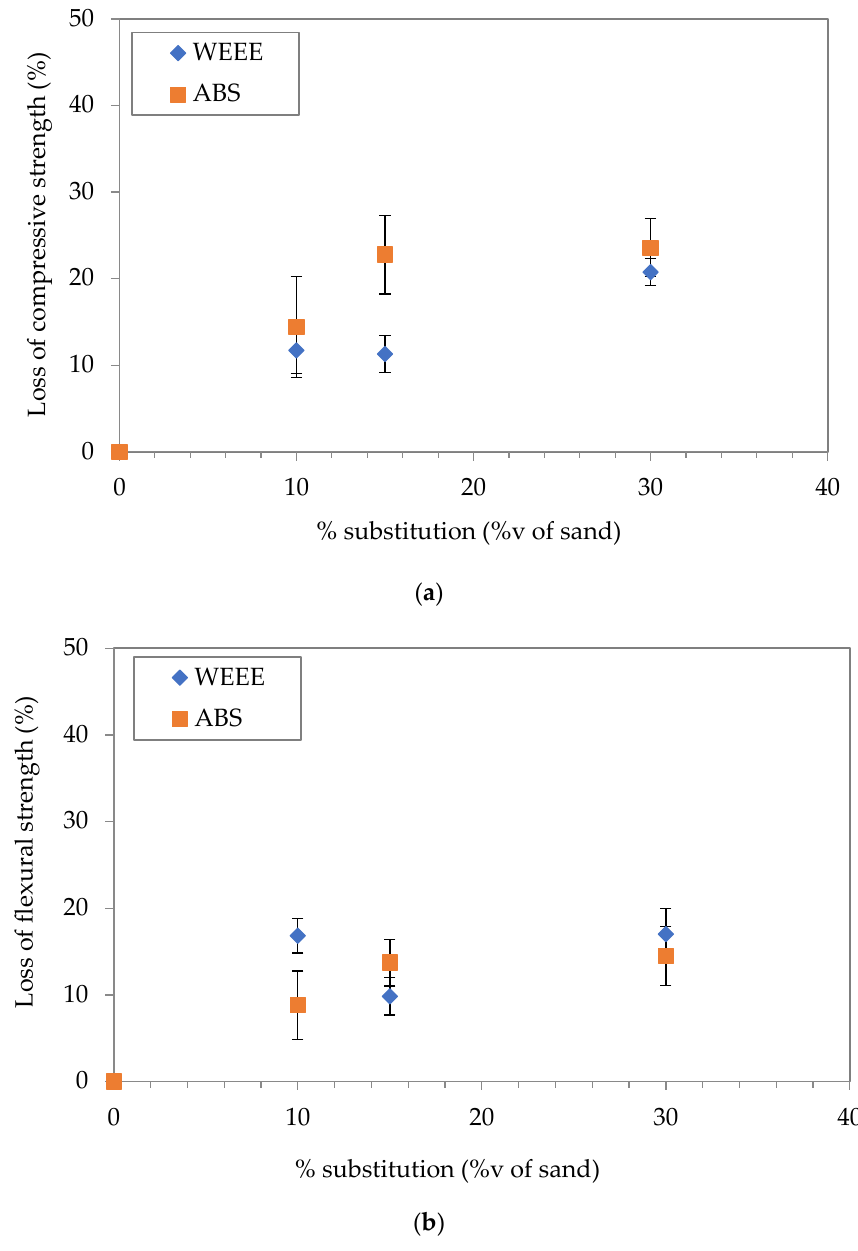
Figure 5. Loss of compressive ( a ) and flexural ( b ) strength compared to reference mortar without plastic aggregates.